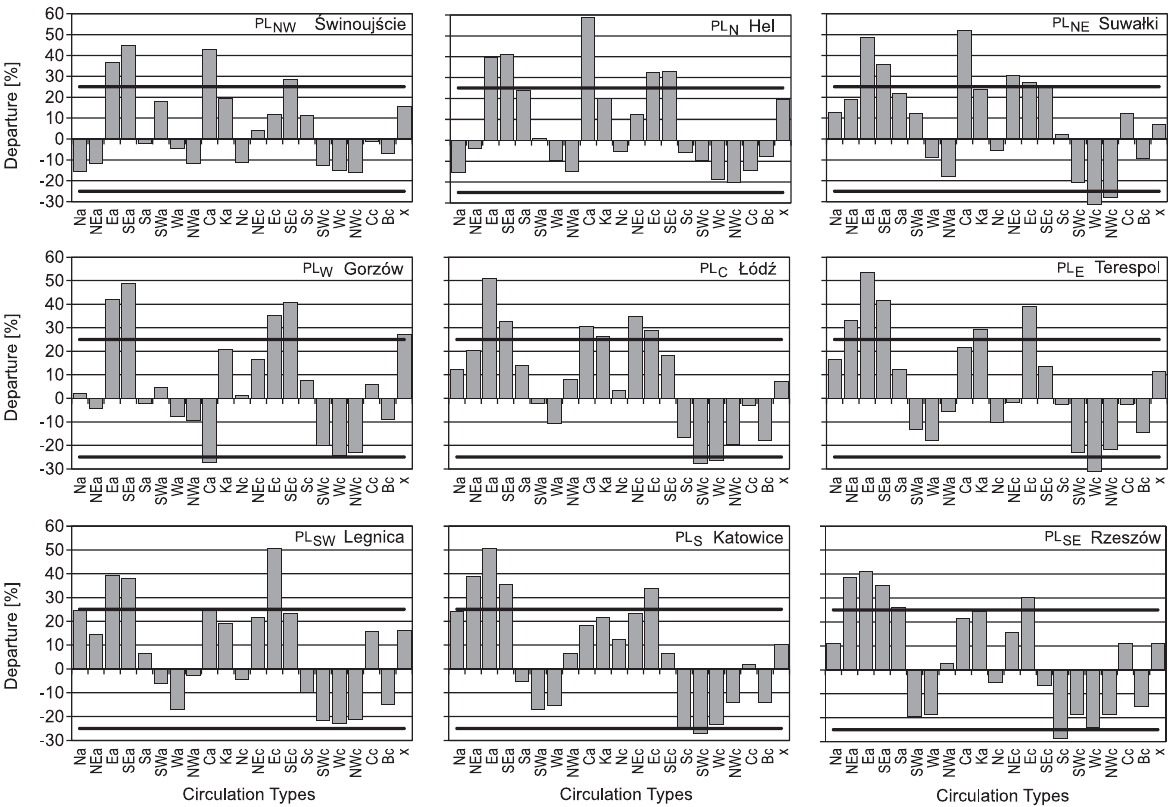
Fig. 4. Departures of the probability of the ice days occurrence in circulation types from the probability of the ice days occur- rence in winter (DJF) for grid boxes within Poland. PL , PL , … etc. – grid box within Poland, e.g.: PL NW N grid box (bold lines mean departures greater than 25%)